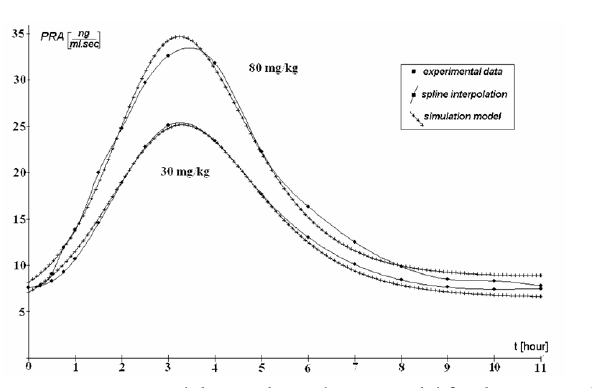
p.229-238.Fig. 7. Experimental data and simulation model for doses 30 and 80 mg/kg Fig. 7.